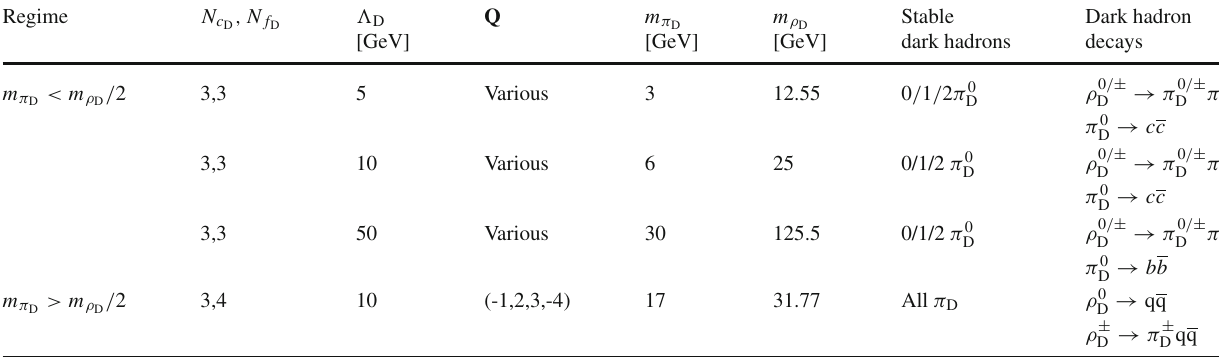
Table 3 Current benchmarks for m π regimes. In the former case all π D are stable and source of (cid:3) E T , while for the later, the ρ D mesons decay to π D which further decay to cc final Regime N c